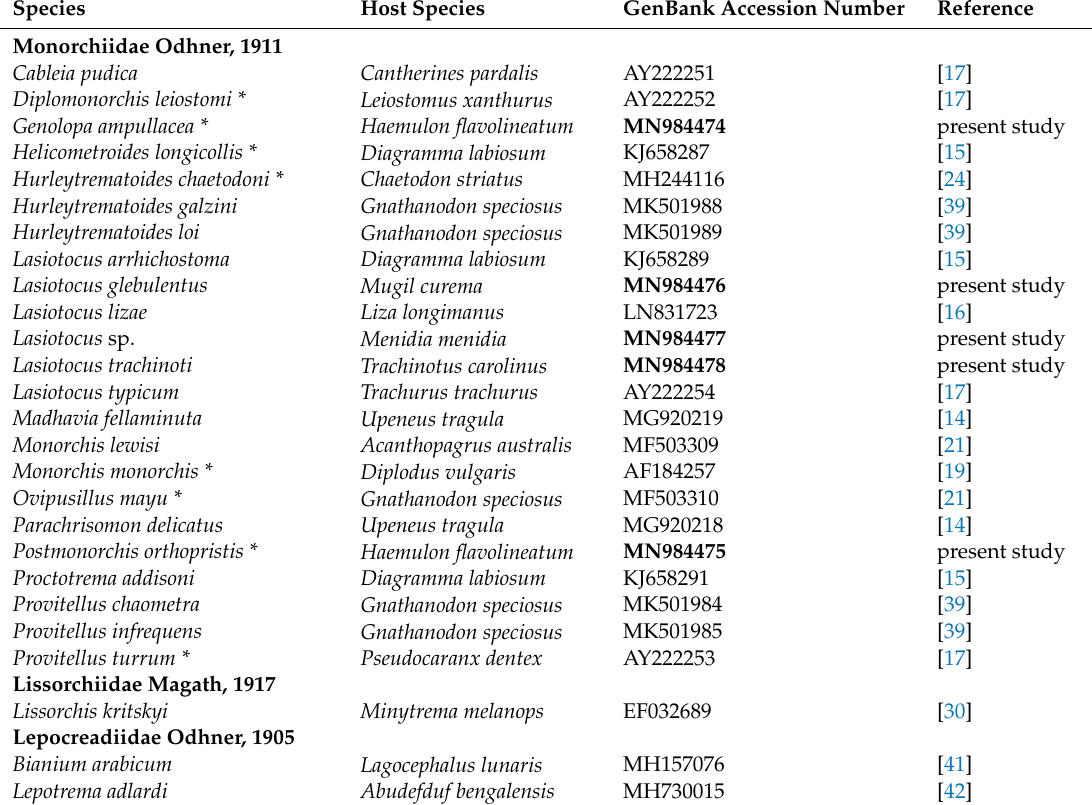
Table 1. Partial 28S rDNA sequence data used in the phylogenetic analysis in this study. Species Host